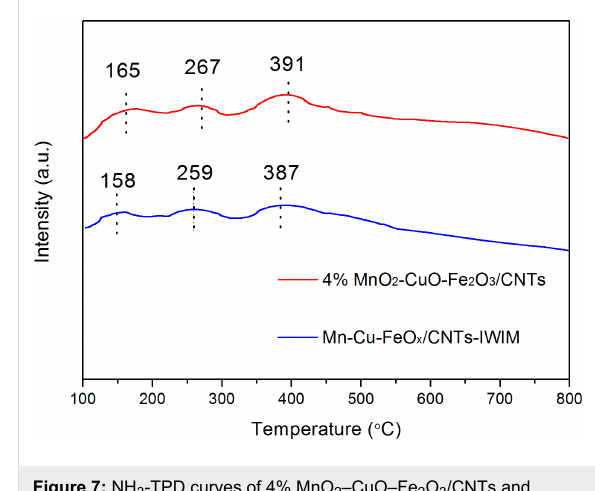
(Figure 6b), the centers of the first and second reduction peaks (257 and 454 °C) were all at higher temperatures than those of 4% MnO 2 –CuO–Fe 2 O 3 /CNTs catalyst. This means that the reducibility is lower compared with that of 4% MnO 2 –CuO–Fe 2 O 3 /CNTs.